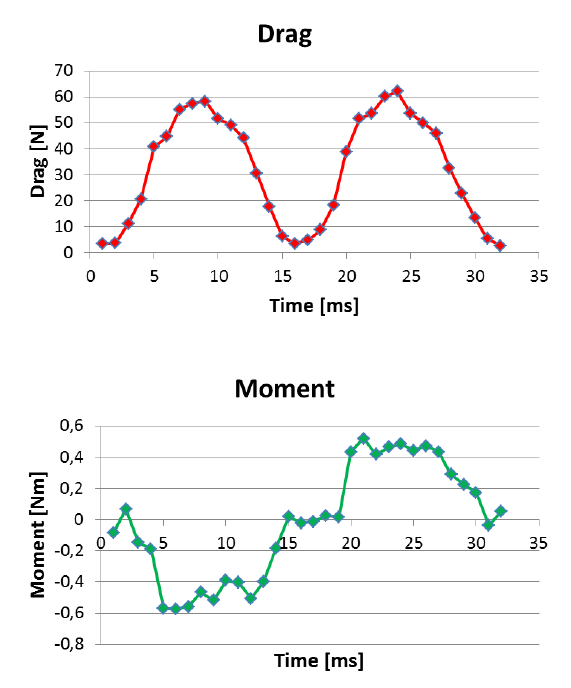
Fig. 7. Total forces: lift, drag and moment for Ma = 0.45.